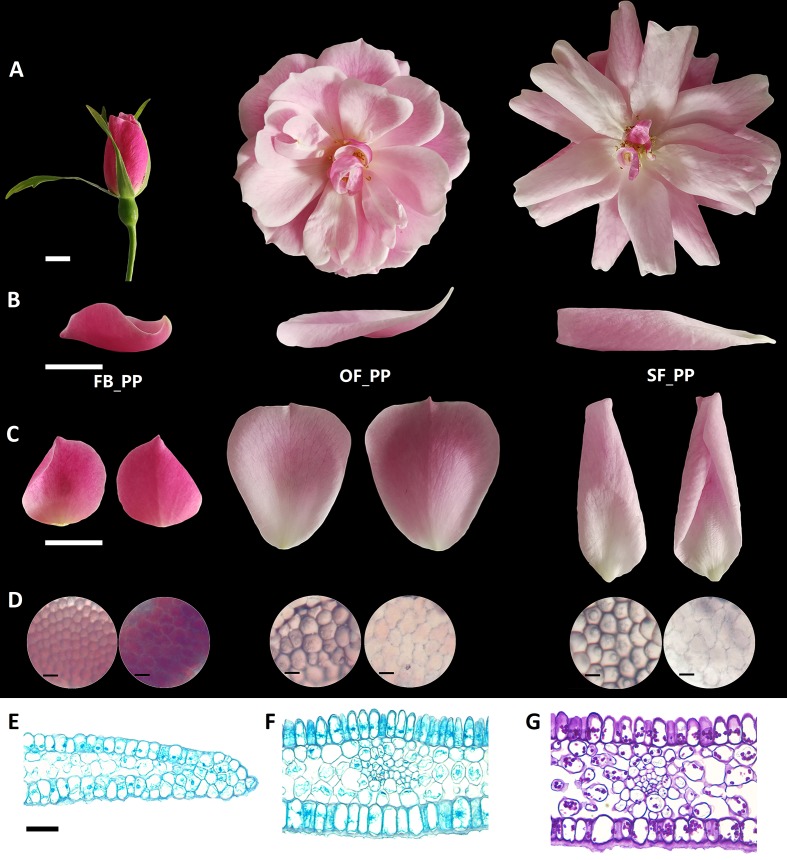
Characterization of the adaxial and abaxial rose petal surfaces. (A) The three stages of petals used in this study, from flower opening to senescence: FB_PP, pink petals in the flower bud; OF_PP, pink petals of the open flower; SF_PP, pink petals of the senescencing flower. Scale bar = 5 mm. (B) Side view of the petals in the three stages. Scale bar = 1 cm. (C) The adaxial (left) and abaxial (right) views of petals in the three stages. Scale bar = 1 cm. (D) Microscopy observation of adaxial (left) and abaxial (right) epidermal cells of petals in the three stages. Scale bar = 50 µm. (E–F) Microscopy observation of cross sections through the FB_PP petal tip (E) and center (Bergougnoux et al., 2007) stained with TB. Scale bar = 100 µm. (G) Polysaccharide distribution in a cross section of the center of a FB_PP petal using periodic acid Schiff (PAS) stain. Scale bar = 100 µm.